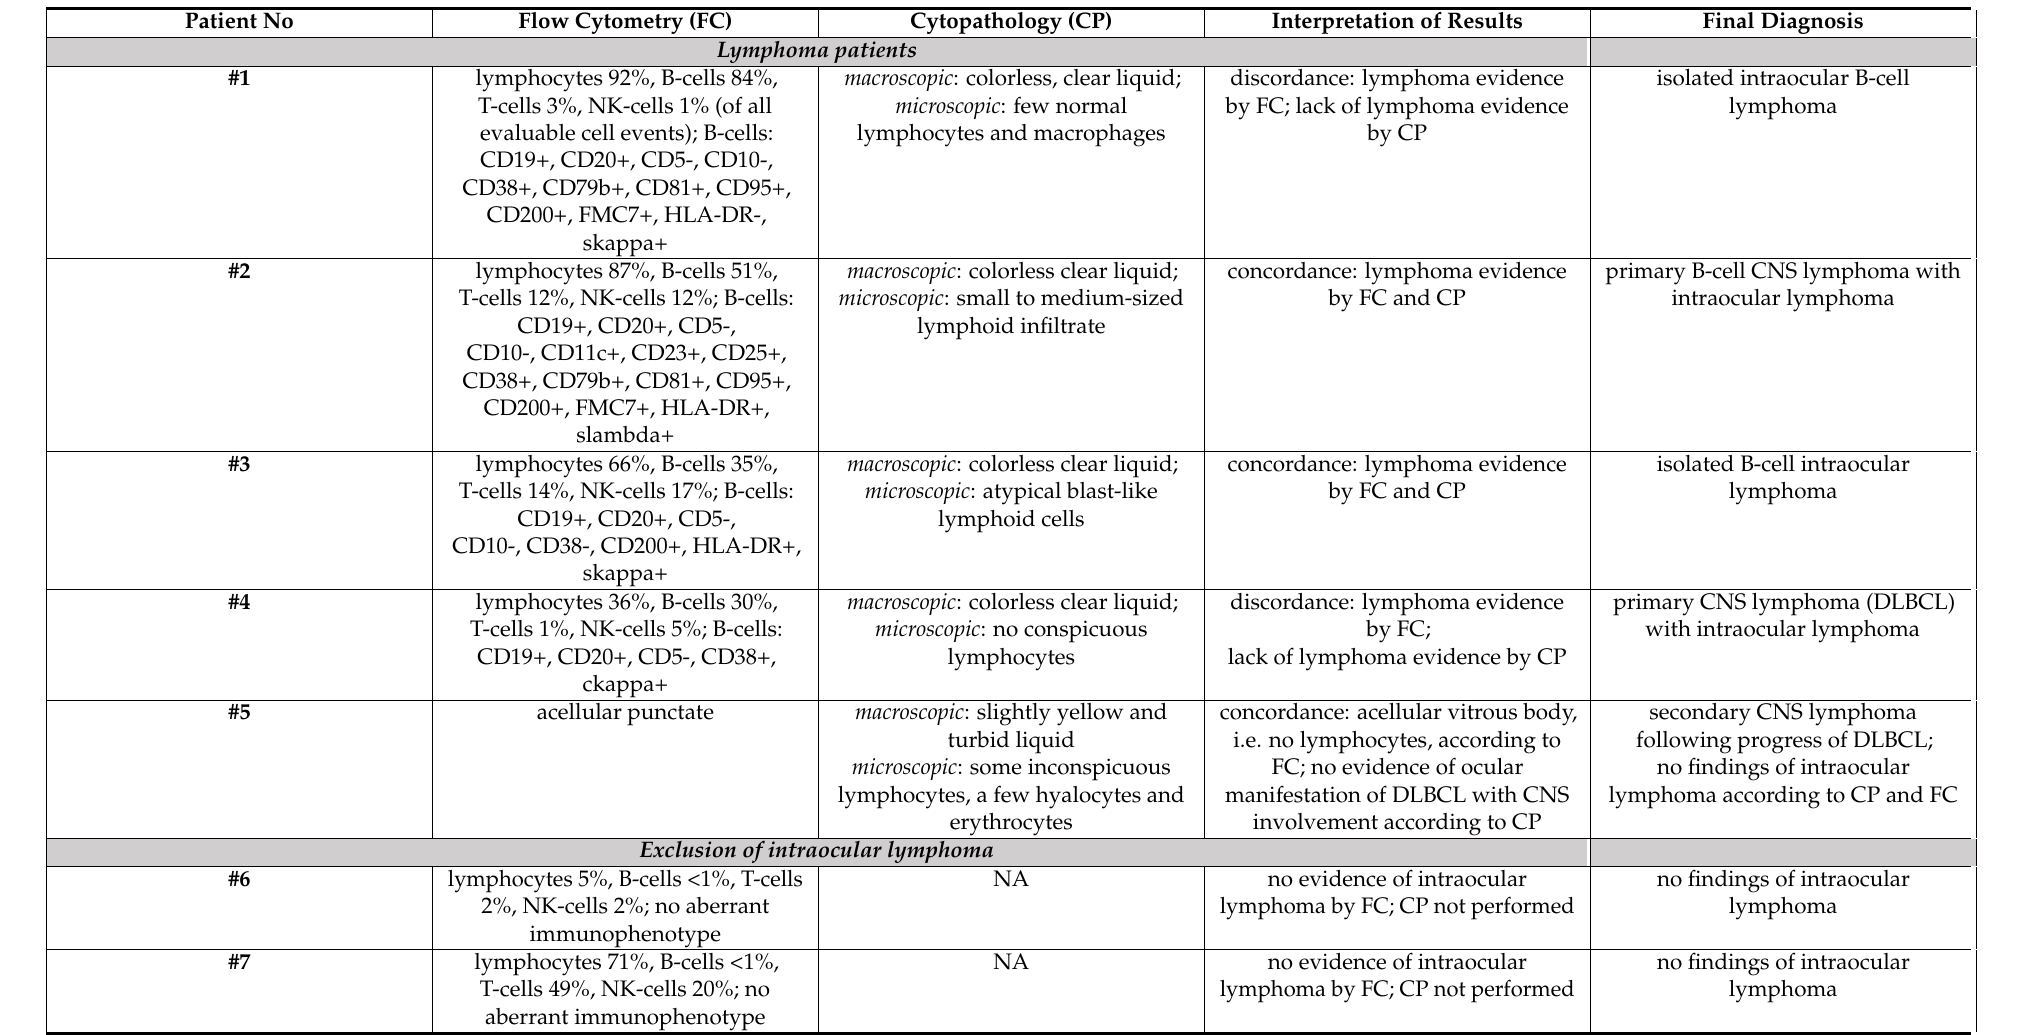
Table 2. Detailed information on the results of flow cytometry and cytopathology of vitreous body in patients of this study. FC, flow cytometry; CP, cytopathology; CNS, central nervous system; DLBCL, diffuse large B-cell lymphoma; i.a, among others; NA, not